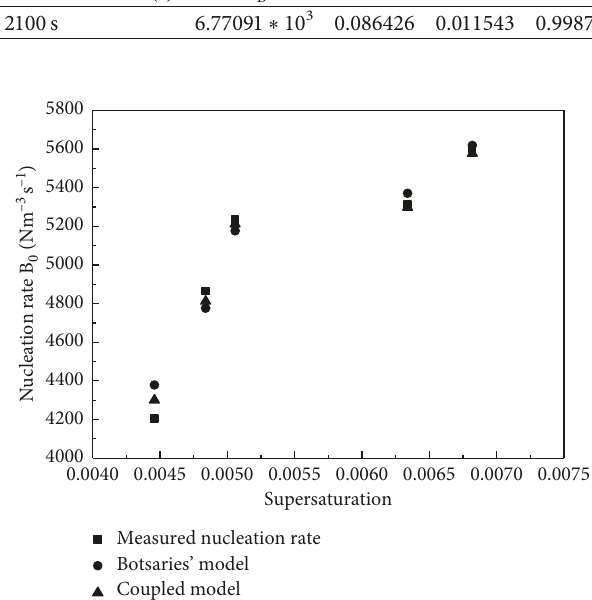
Figure 15: Comparison of the predicted and measured nucleation